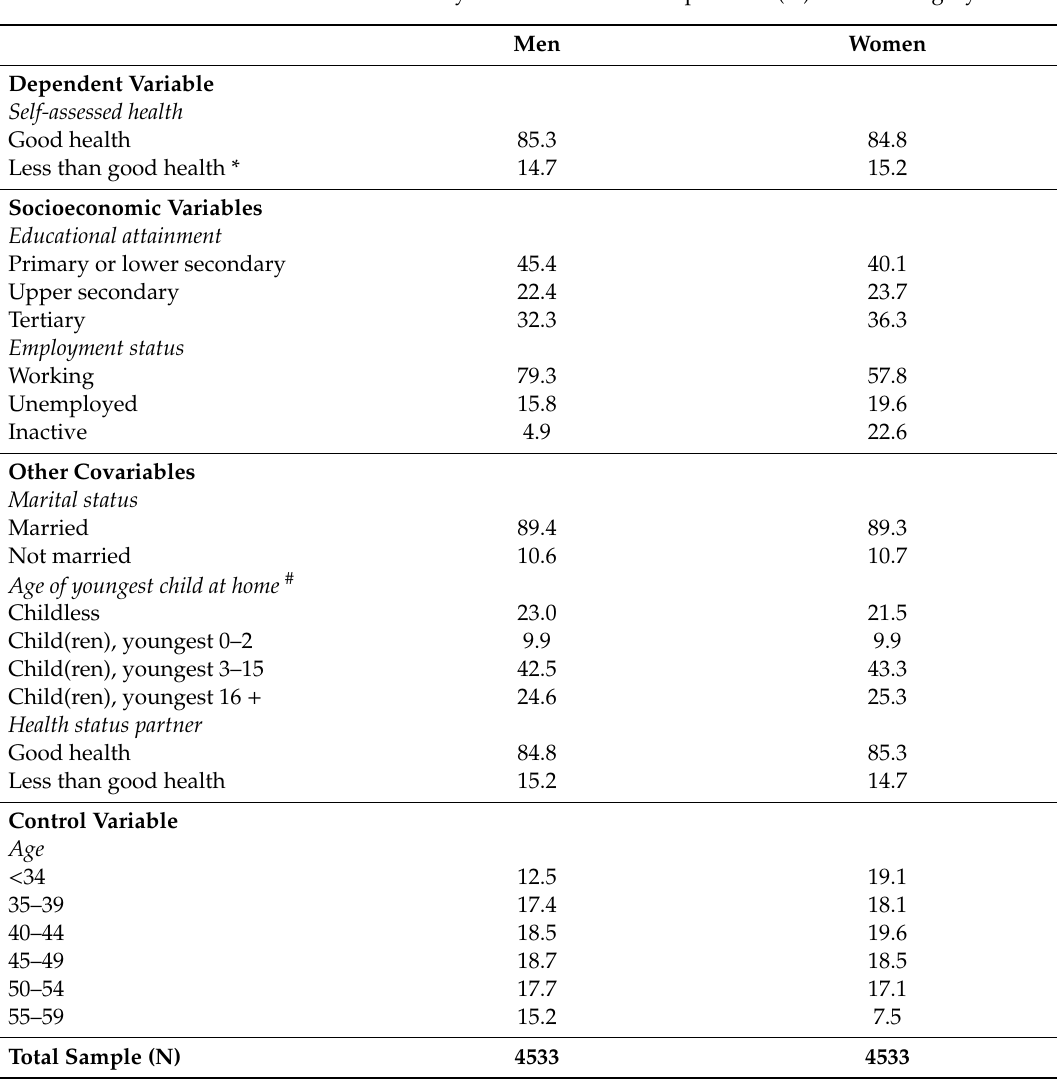
Table 1. Variables included in the analysis and the relative importance (%) of each